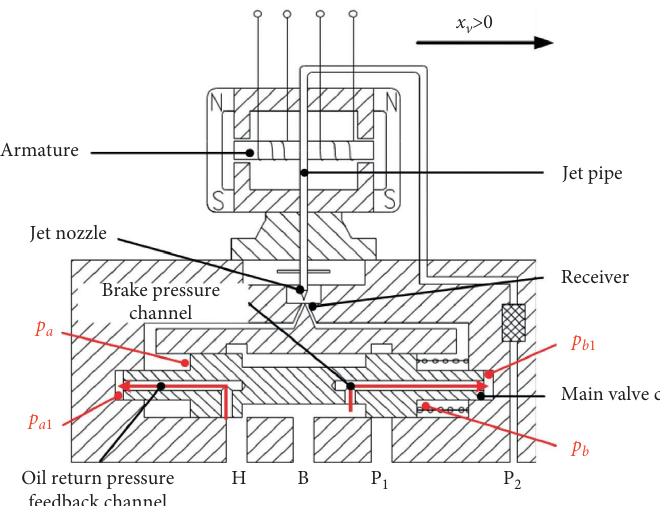
Figure 10: Two-stage brake pressure servo valve